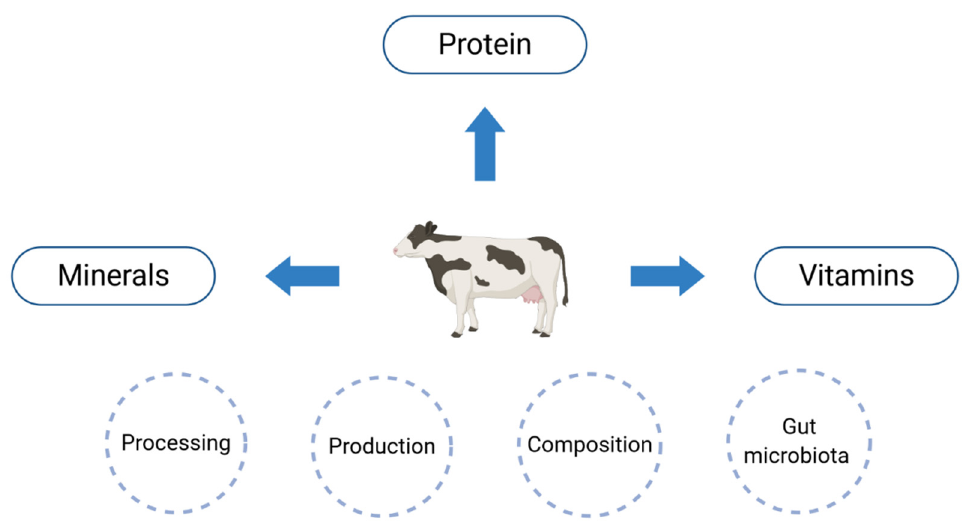
Figure 2. The effect of cow’s milk on bone.